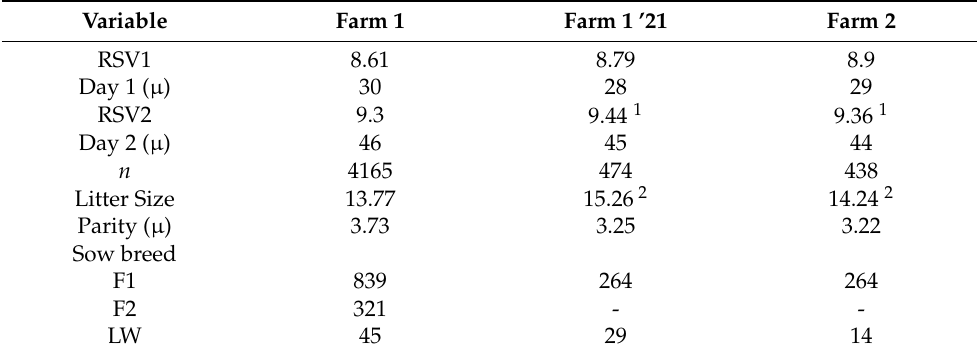
Table 1. Mean RSV, litter size, parity number, and breed of the sows from Farm 1 (overall), Farm 1 ’21, and Farm 2. Variable Farm